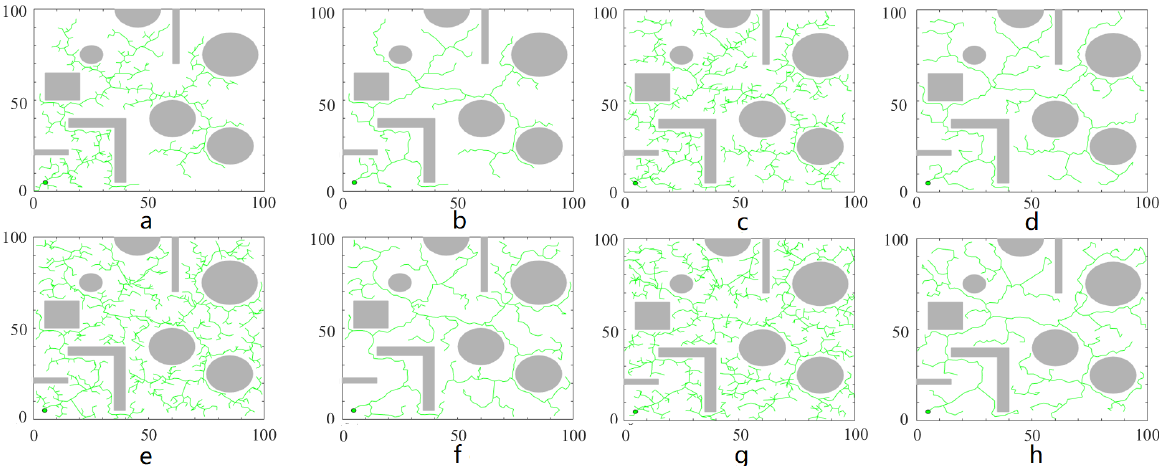
Figure 11. Expand tree using Algorithm 2 ( a \ c \ e \ f , expansion of tree after 500 \ 1000 \ 2000 \ 4000 sampling, c \ e \ f , the expan- sion is based previous withered tree, b \ d \ f \ h , wither the tree in previous expansion with len = 4).